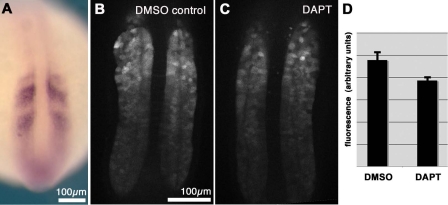
Effect of Loss of Notch Signalling on the Expression of a GFP Reporter for her1
(A) ISH staining for gfp mRNA in a transgenic embryo shows a pattern of expression similar to the normal her1 expression pattern.(B) GFP fluorescence of a transgenic embryo in the living state treated with DMSO (control), as seen by confocal microscopy in an optical section. Note that the magnification is higher than in (A), and the optical section shows only the PSM.(C) Corresponding embryo treated with DAPT and imaged in the same way as in (B).(D) Measured average fluorescence intensities in the PSM of transgenic embryos containing the reporter, after treatment with either 100 μM DAPT or DMSO (control) medium. Treatment was from 5.5 hpf up to 16-somite stage. Fluorescence levels were lower in the DAPT-treated embryos than in the controls by a factor of 0.81 ± 0.07 (mean ± SEM, n > 12 embryos of each type). Error bars show standard error of the mean.